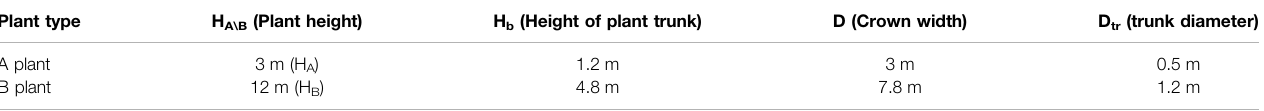
TABLE 1 | Plant characteristic size in numerical simulation.